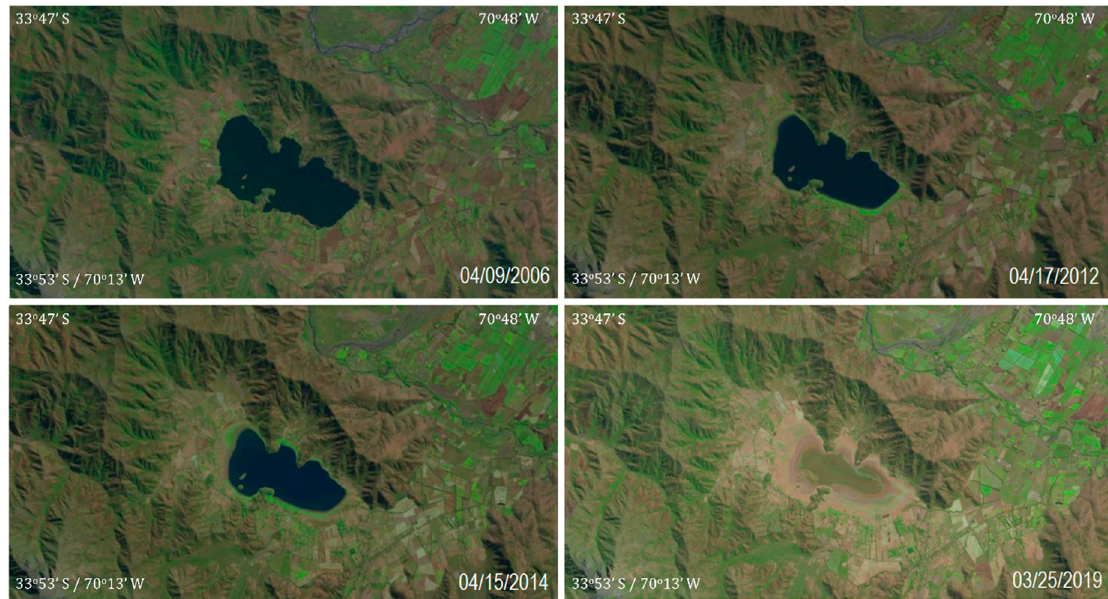
Figure 2. Evolution of the Aculeo Lagoon between 2006 and 2019. Its complete disappearance process started in 2012 and finally occurred on May 2018. The composite is based on Landsat ETM+ images.